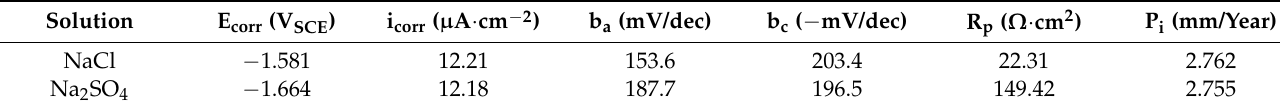
Table 4. The fitting result of the WE43 cathode polarization curve.